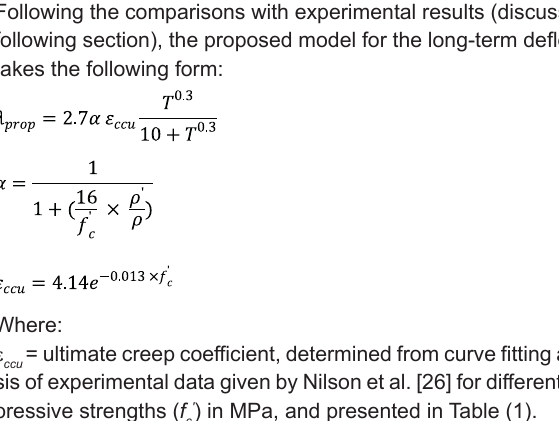
Validation of proposed long-term deflection multiplier ( time of sustained loading = 2.5 years Beam No.